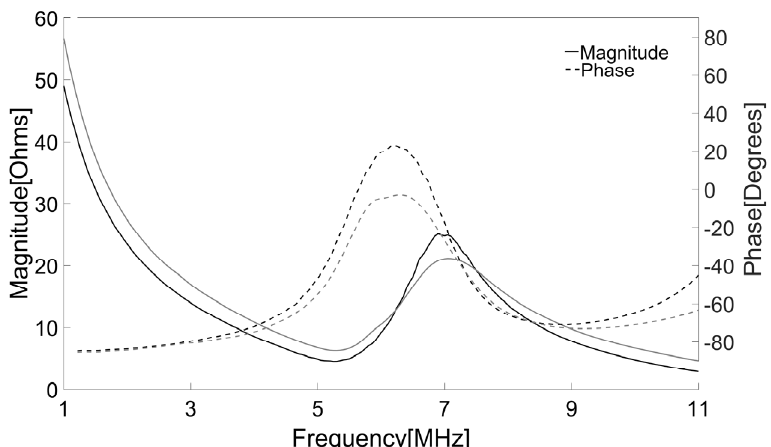
Figure 9. Measured electrical impedances of the press-focused (black) and double-focused (gray) transducers. The solid line represents impedance magnitude and the dotted line is phase angle.